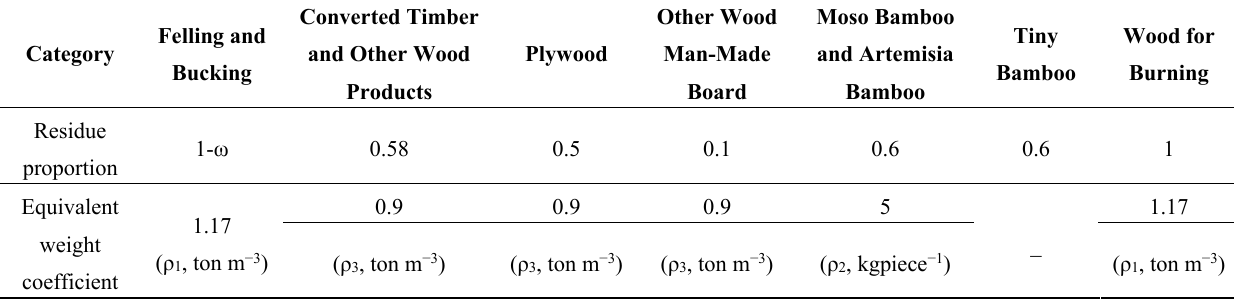
Table 2. Parameters for the estimation offorest biomass energy resources.